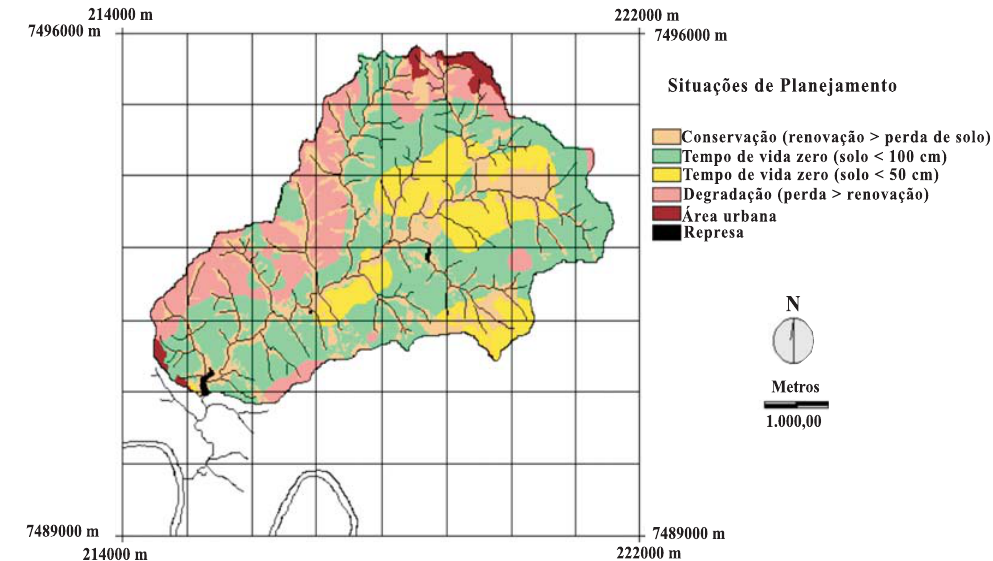
Figura 3. Mapa das situações de planejamento da área de estudo, de acordo com o método do índice de tempo de vida do